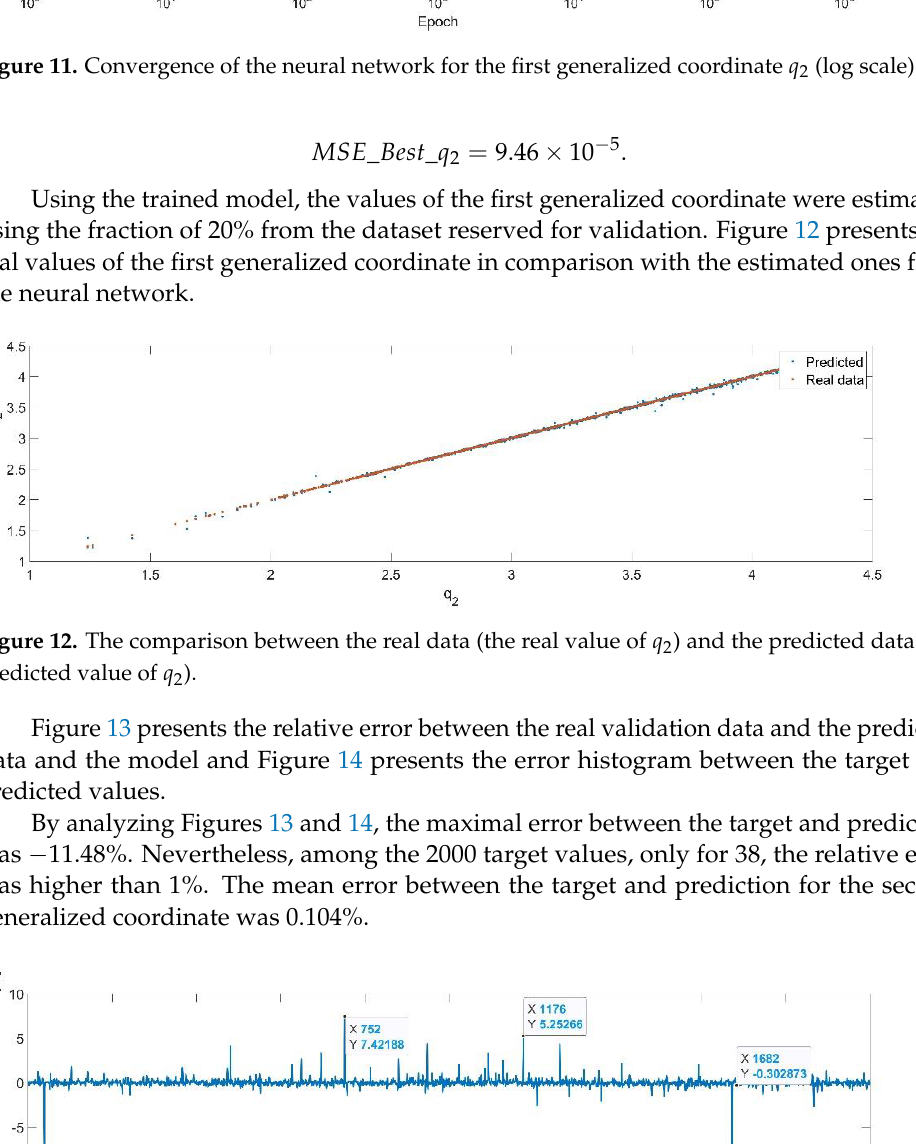
Figure 14. Error histogram between the target values and the estimated values for 𝑞 2 . By analyzing Figures 13 and 14, the maximal error between the target and prediction was −1 1.48%. Nevertheless, among the 2000 target values, only for 38, the relative error was higher than 1%. The mean error between the target and prediction for the second generalized coordinate was 0.104%. 4.3.3. Results for the First Generalized Coordinate 𝑞 3 Figure 15 presents the convergence of the neural network on a logarithm scale. From the 1st epoch to the 1000th epoch, the mean squared error reached from 9.71 to 1.07 × 10 −3 . In the 1 millionth epoch, the MSE reached its lowest value, as in Equation (31). Figure 15. Convergence of the neural network for the first generalized coordinate 𝑞 3 (log scale). 𝑀𝑆𝐸_𝐵𝑒𝑠𝑡_𝑞 3 = 7.8 × 10 −5 . (31) Using the trained model, the values of the first generalized coordinate were esti- mated, using the fraction of 20% from the dataset reserved for validation. Figure 16 pre- sents the real values of the first generalized coordinate in comparison with the estimated ones from the neural network.